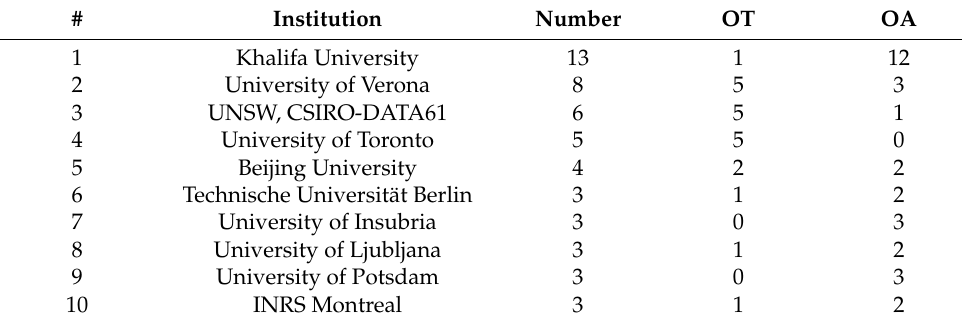
Table 11. Most productive